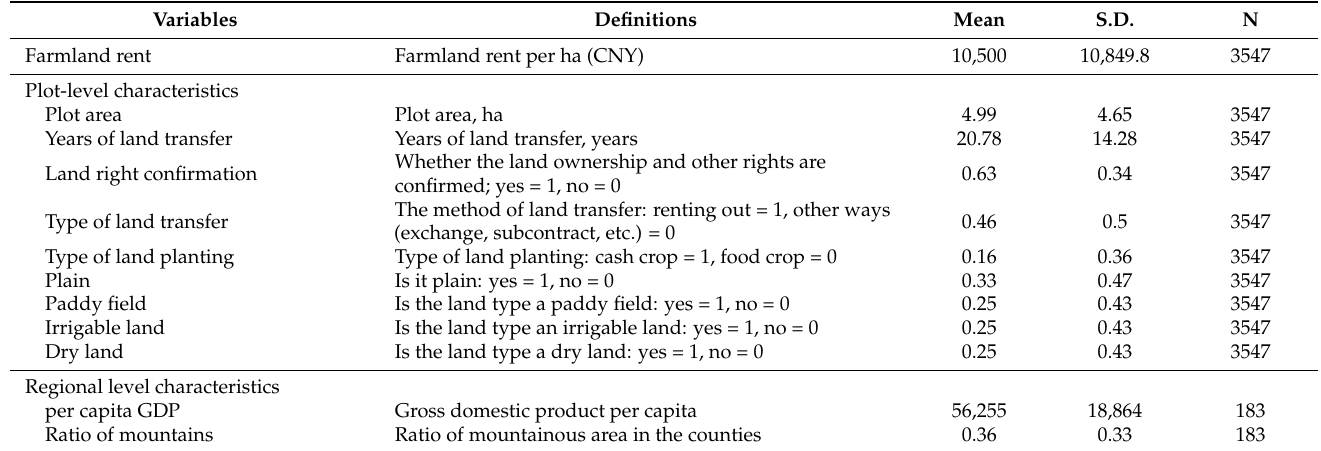
Table 1. Definitions and statistical descriptions of variables.